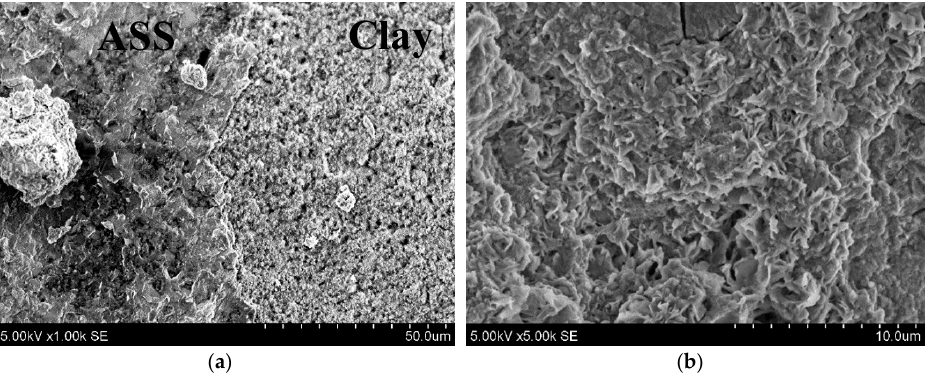
Figure 8. The SEM images of the contact zone between AAS and clay ( a ) and the microstructure of AAS ( b ).